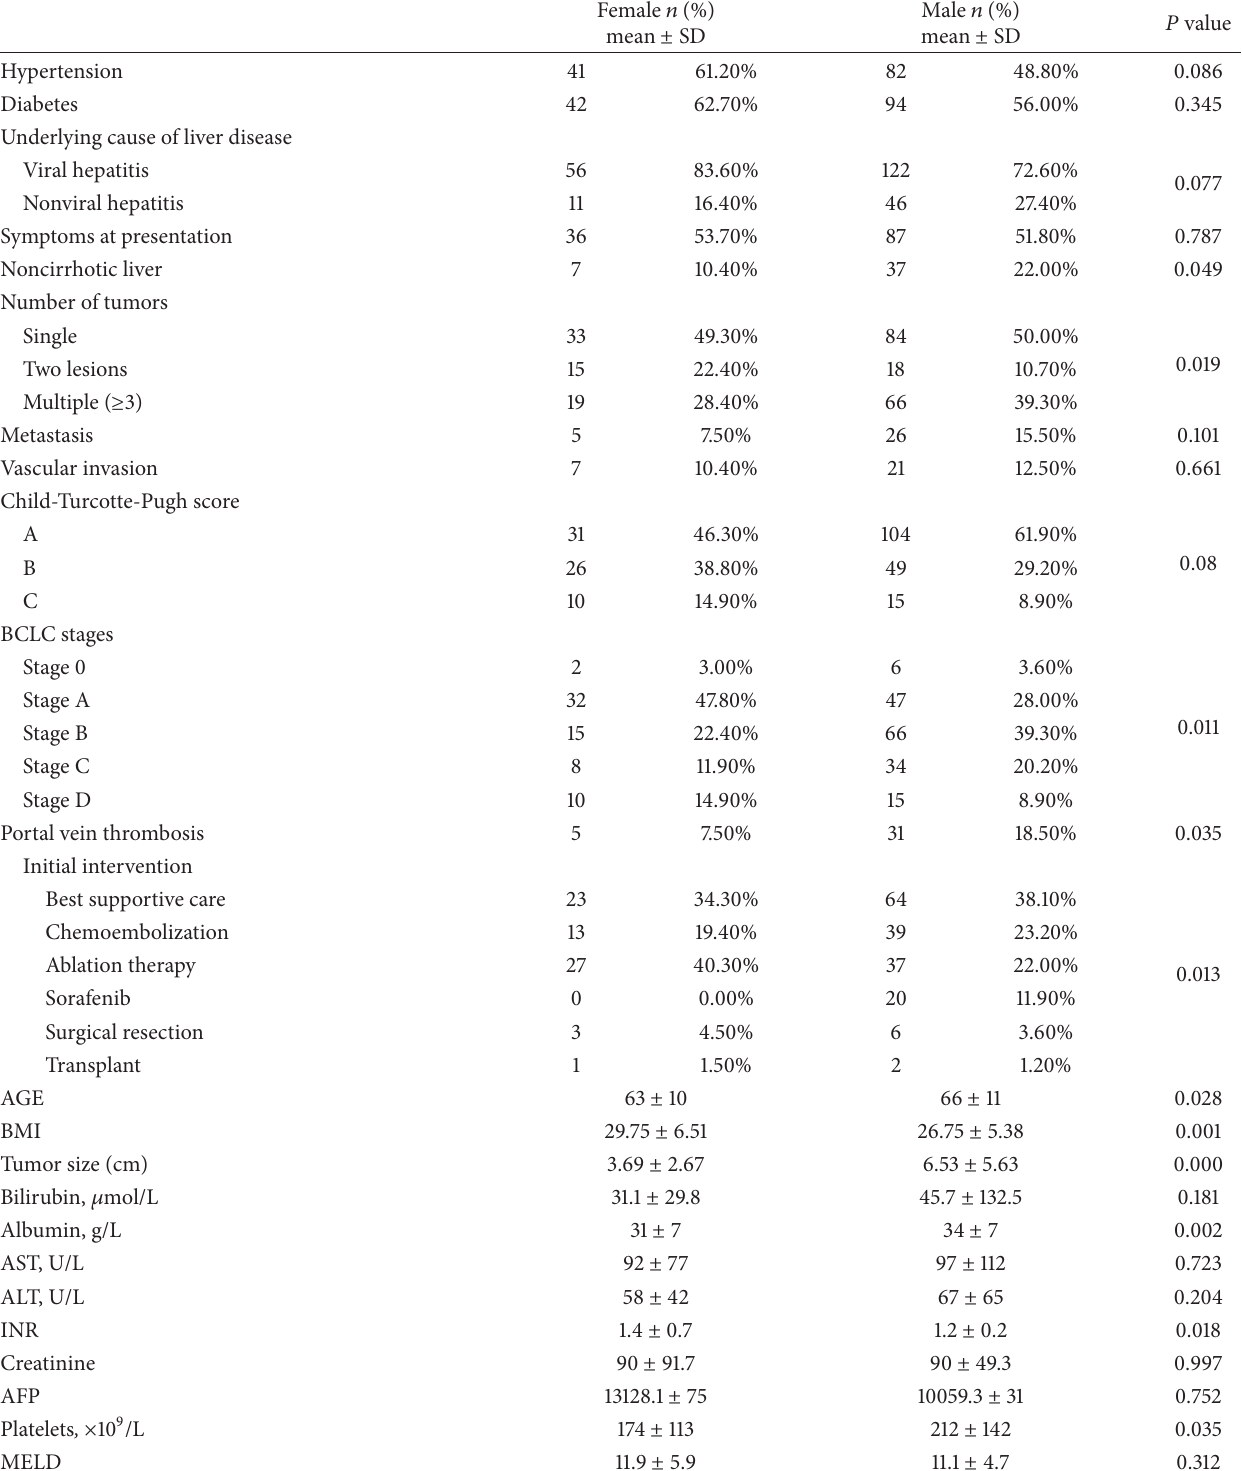
Table 3: Comparison of demographic characteristics, tumor factors, and treatment modalities between male and female